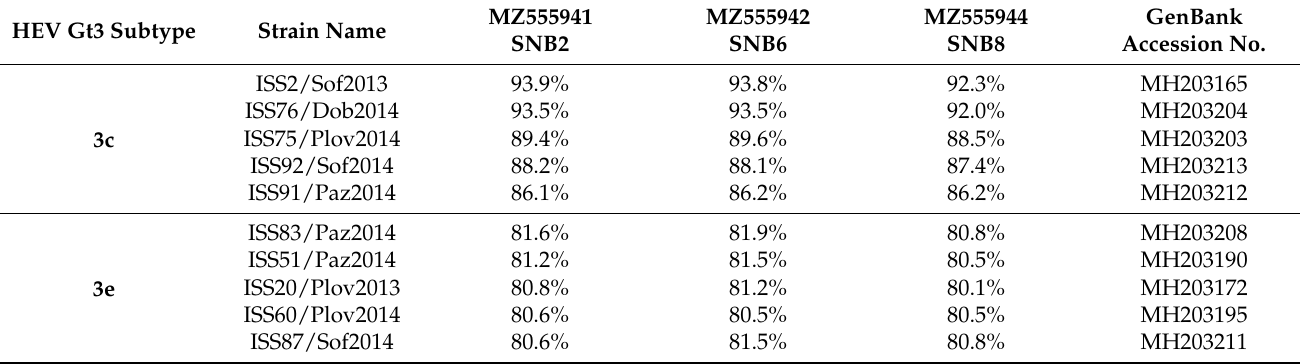
Table 3. Nucleotide (nt) sequence identity matrix (%) based on the partial ORF2 gene of a selection of human HEV strains identified in Bulgaria [10]. The swine strains detected in this study are in bold.